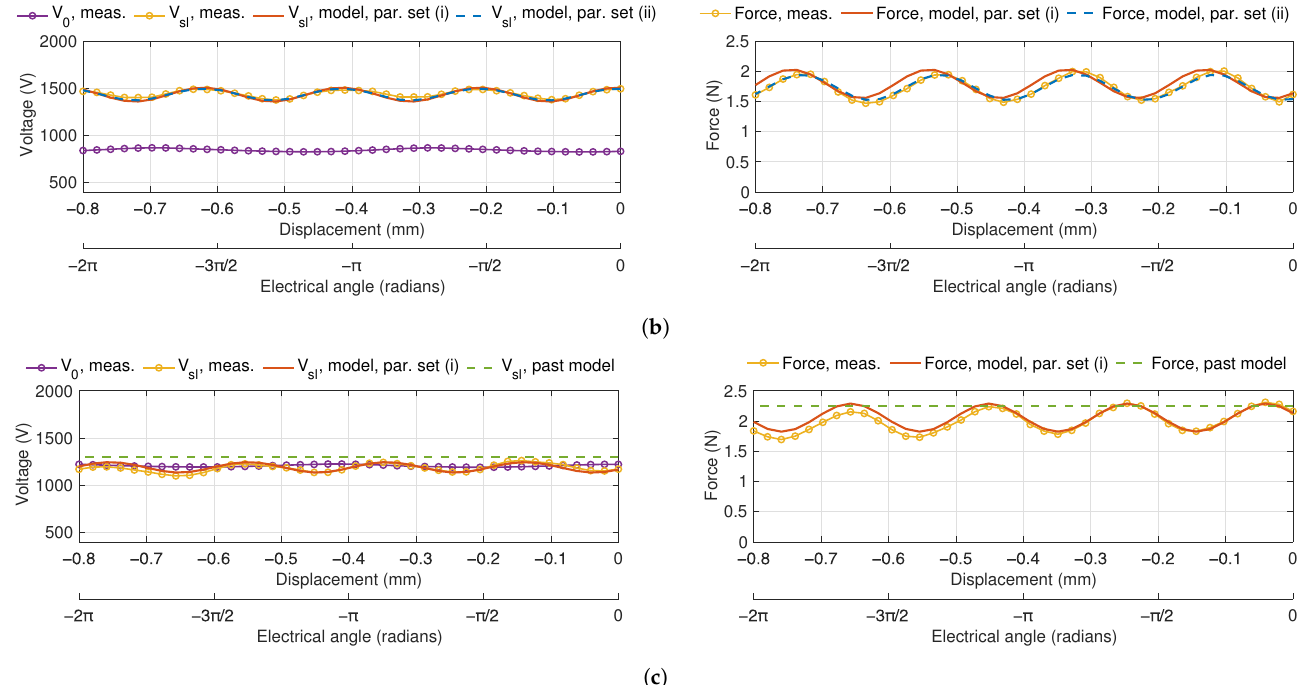
Figure 8. Main force and voltage measurement results and comparison to the two model implementations: (i), using measured inductance values and (ii), using “optimized” inductance values. ( a ) Using only the inductor ( R ≈ 305 Ω ). ( b ) With external resistance connected in series ( R ≈ 804 Ω ). ( c ) With external resistance connected in series ( R ≈ 1918 Ω ). Model (ii) was not generated for this set of results. Results using past model included for